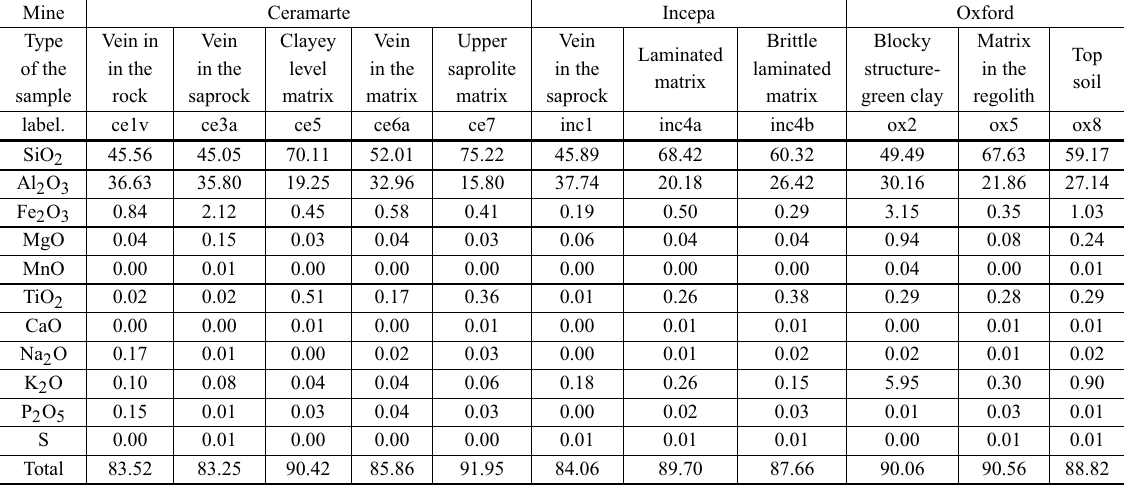
XRF analysis (wt. %) of major elements of 11 bulk samples from kaolin clays of Campo Alegre